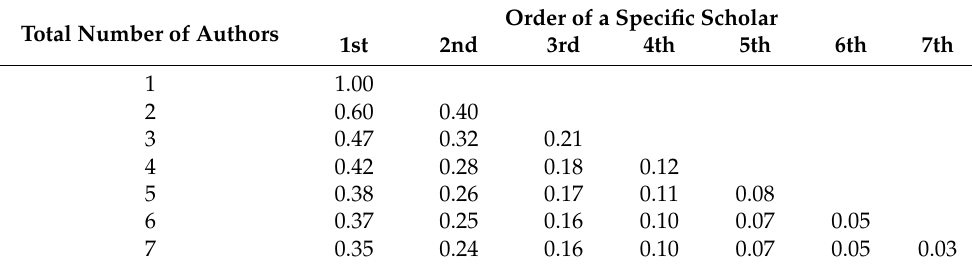
Figure 11. Highly productive authors and clusters. Table 4. Contribution score for a multi-author